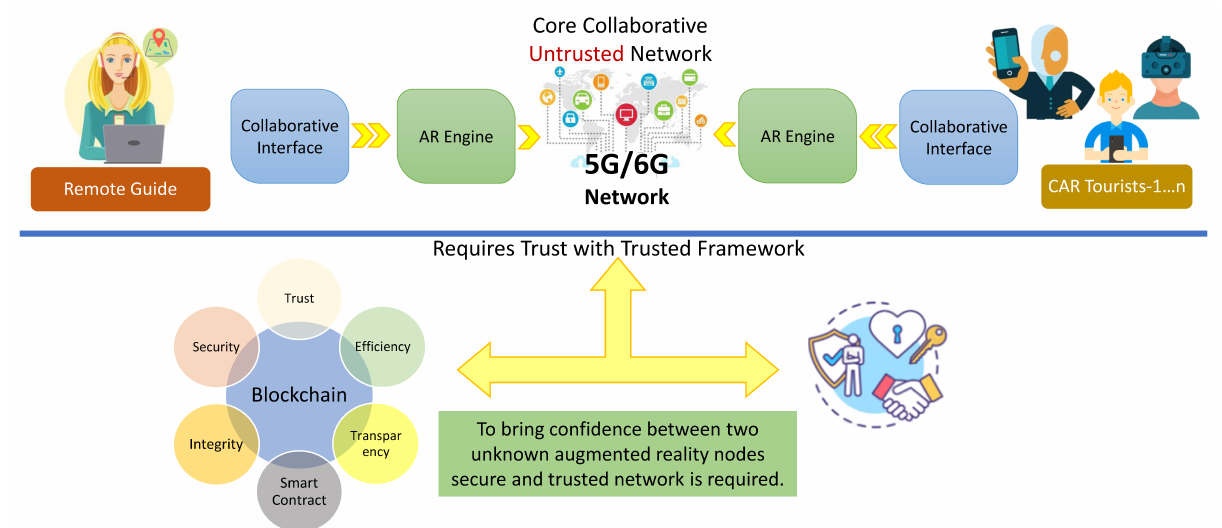
Figure 2. Problems with the existing AR Collaborative Application and the solution of such